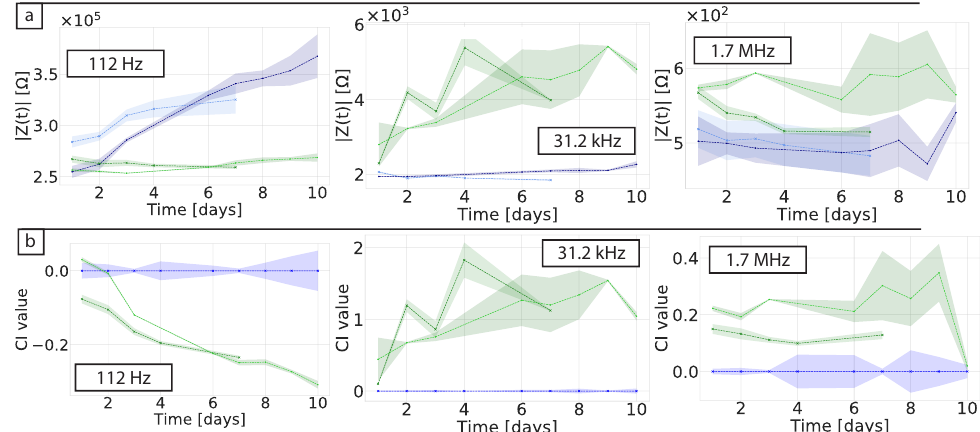
Figure 3. ( a ) Impedance magnitude and ( b ) cell index (CI) changes over-time at 112 Hz, 31.2 kHz and 1.74 MHz. Measurements were taken daily while the electrodes were incubated in standard culture conditions. For the CI the impedance was normalised to the average of the samples containing DMEM + FBS. Blue lines are from wells containing DMEM + FBS medium and green lines are from wells seeded with 3 × 10 4 cells in medium. Shaded area shows minimum and maximum of the